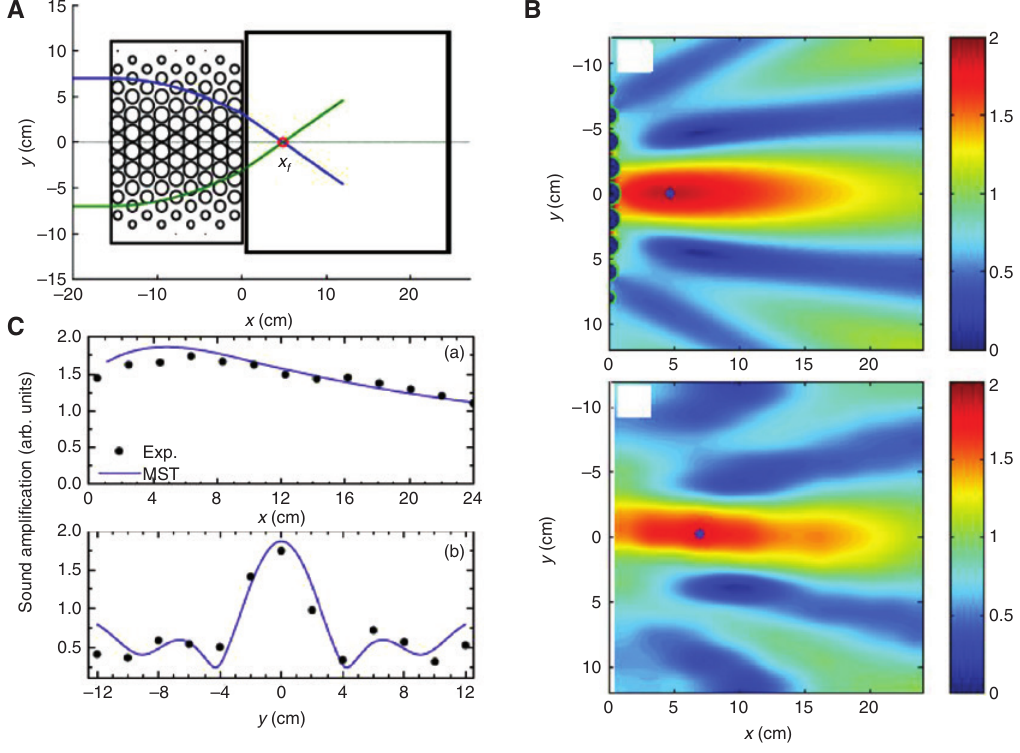
Figure 4: Sonic GRIN flat lens. (A) Schematic view of a GRIN lens with the ray trajectory. For the impinging plane sound wave, the rays will bend and focus at x the right side of the lens. (B) Normalized sound amplitude at 4.5 kHz mapped at the right side of the GRIN lens from the multiple scattering method (upper panel) and the experiment (lower panel). (C) Normalized sound amplitude along the x and y axes crossing the focusing point. Blue lines stand for simulation, and black dots stand for experiment